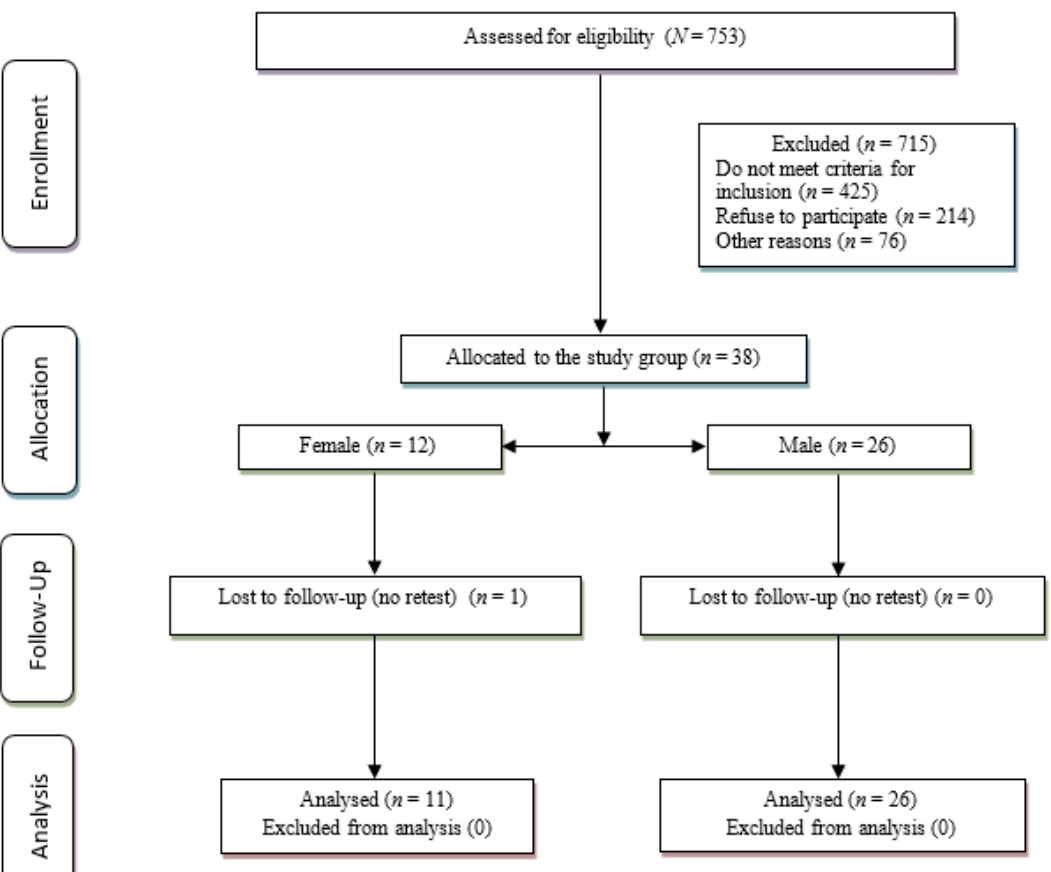
Figure 1. Flowchart of the results of the sample recruitment.